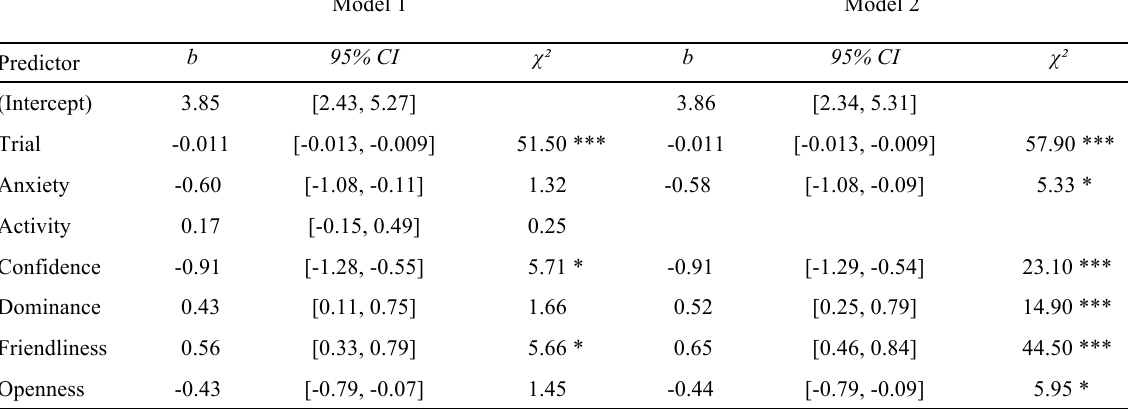
Details of Linear Regression Models of Interest, Predicting RTs from Personality Model 1 Model 2 Predictor